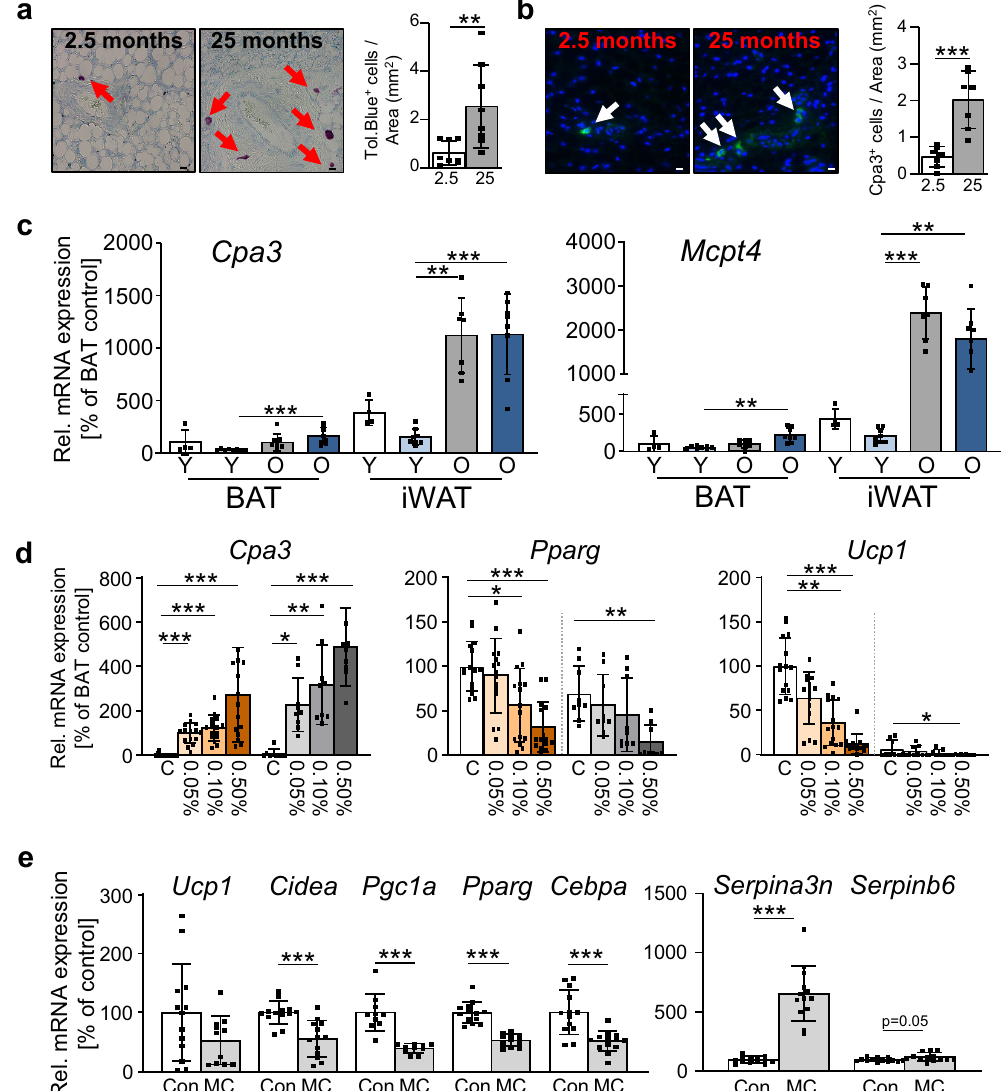
Figure 3. Aging results in mast cell accumulation which impairs brown adipogenesis. ( a ) Toluidine blue staining of BAT- sections of young (2.5 months, left panel; n = 7) and aged mice (25 months; middle panel, n = 7) and subsequent cell count- based quantification (right panel) of stained mast cells (red arrows) normalized to total section area using sections of BAT. For each animal, 1–2 independent tissue sections per animal were assessed. Images were collected at 600-fold magnification (scale bar: 10 µm). ( b ) Immunofluorescence analysis of cells expressing mast cell marker carboxypeptidase A3 (CPA3) in BAT-sections of young (2.5 months, left panel; n = 8) and aged mice (25 months; middle panel, n = 8) and subsequent cell count-based quantification (right panel) of stained mast cells (green signal, white arrows) normalized to total section area using sections of BAT. For each animal, 1–2 independent tissue sections per animal were assessed. Images were collected at 600-fold magnification (scale bar: 10 µm). ( c ) mRNA levels of mast cell markers Cpa3 and Mcpt4 in BAT (left) and iWAT (right) of young mice maintained at room temperature (RT; white bars) or of young mice after 7 days of cold exposure (light blue) were compared to mice aged 25 months at RT (grey bars) or 25-month old mice after 7-day cold exposure (dark blue). Data are depicted as mean ± standard deviation (SD; n = 4 for 2.5 months BAT and iWAT; n = 8 for all cold exposed tissues and aged BAT)-8 mice; n = 7 for aged iWAT). ( d ) mRNA expression of Cpa3 , Pparg and Ucp1 of primary brown (left, orange) and white (right, grey) adipose tissue-derived progenitors co-seeded with 0.05, 0.1 or 0.5% of p815-mast cells compared to control cultures without masts cells (control; C) after 10 days of differentiation (n = 15, from 3 independent repeat-experiments for BAT; n = 9 from 2 independent repeat experiments for iWAT). ( e ) mRNA expression of brown adipocyte marker genes Ucp1 , Cidea , Ppargc1a , Pparg , Cebpa and of mast cell protease inhibitors Serpina3n and Serpin6b in in vitro differentiated brown adipocytes exposed to control conditioned media (white) or mast cell-conditioned media (light grey) for 24 h (n = 12 for Ppargc1a from 2 independent experiments; n = 15 for all other genes, from 3 independent repeat-experiments). All data (see Suppl. Table S5 for full gene names) are depicted as mean ± standard deviation (SD); *p < 0.05, **p < 0.01, ***p < 0.001 using a nonparametric Kruskal–Wallis test for multiple comparisons of panels with multiple BAT- or iWAT-samples, respectively, and non-parametric Mann–Whitney test for panels with pairwise